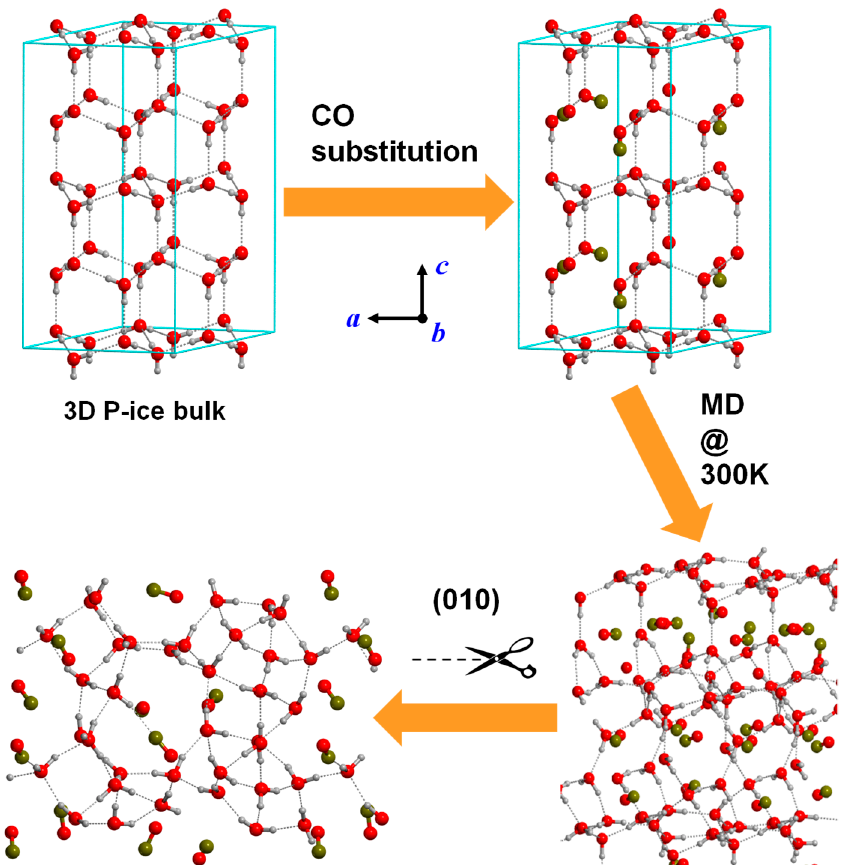
Figure 4. Stepwise strategy to obtain an amorphous surface as a model for a dirty ice mantle con- sisting of H 2 O:CO (75:25). Step (i) replacement of H2O molecules of the crystalline water P-ice bulk system by CO molecules (according to the H 2 O:CO ratio). Step (ii) running MD simulation at 300 K on the H2O/CO crystalline-like system to amorphize the structure. Step (iii) slab-cut procedure on the amorphous H 2 O/CO bulk structure to reach an amorphous H 2 O/CO slab surface model as a final product.